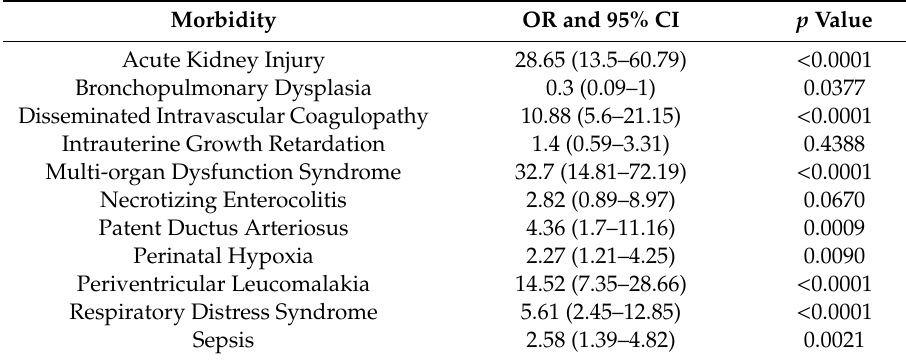
Table 4. Univariate analysis results for morbidities a ff ecting neonates’ survival.